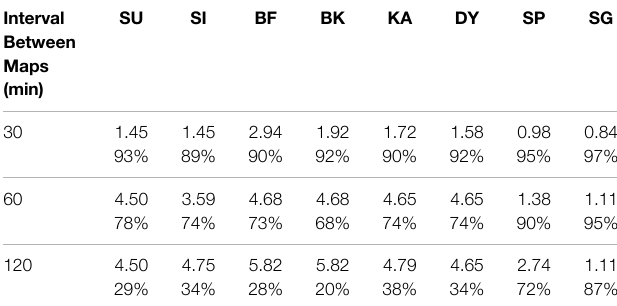
TABLE 7 | Maximum distance (m) traveled while not being re-localized and the percentage of frames re-localized under 55 cm of the last re-localization. Interval SU SI Between Maps (min)